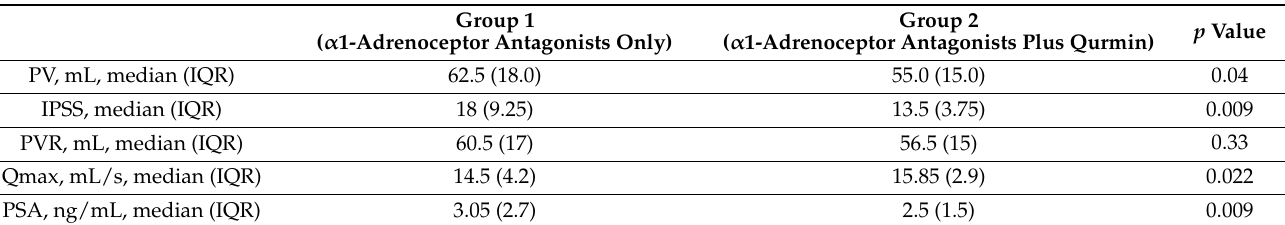
Table 2. IQR: interquartile range. PSA: prostate-specific antigen. PV: prostate volume. IPSS: Interna- tional Prostate Symptom Score. PVR: post-voiding residual.